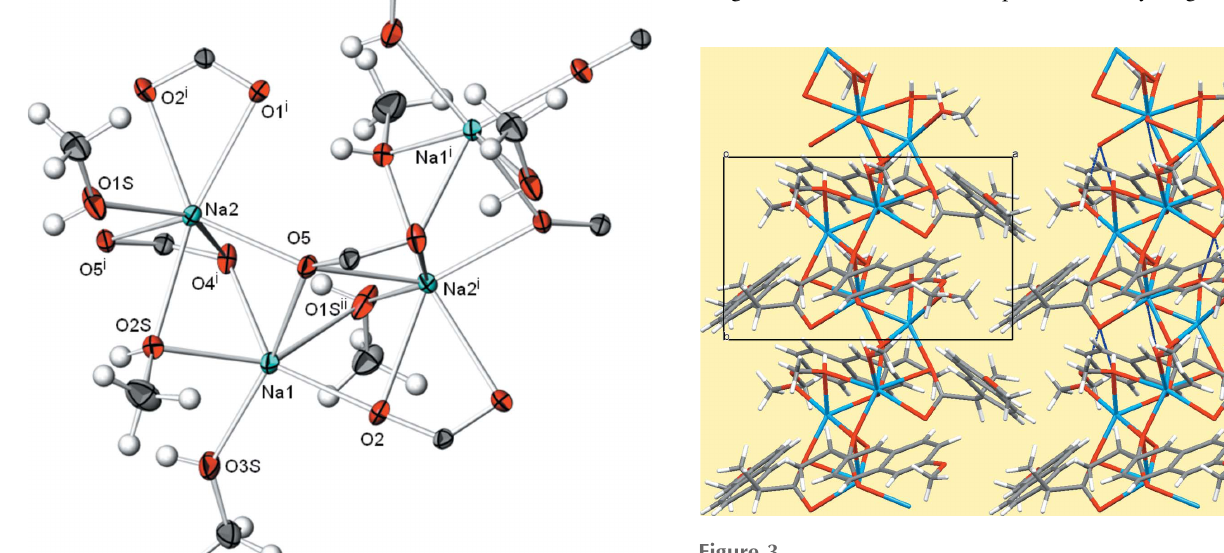
Figure 3 The crystal structure of (I) in a projection along [001]. O—H (cid:2)(cid:2)(cid:2) O hydrogen bonds within a ribbon are displayed in blue on the right hand side. For clarity, only the major part A of the disordered 6-methoxy- naphthyl moiety is